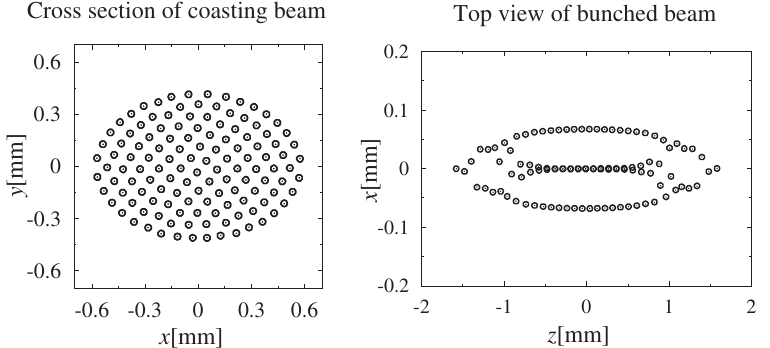
FIG. 4. Examples of multidimensional crystalline beams generated in the regular operating mode of Test Ring I by means of tapered cooling. The friction coefficients assumed here are f 0 : 315 that is evaluated from the theory in Ref. [15]. The line density of the coasting beam is 1 : 3 (cid:11) 10 6 m (cid:1) 1 . The number of ions in a bunch is 100 in the right panel. The synchrotron tune has been set at